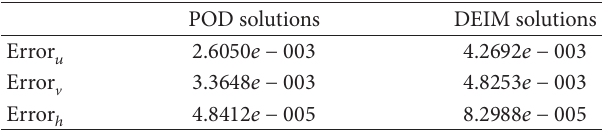
Table 1: Average relative errors for each of the model variables. The POD basesdimension is28capturing morethan 99.9% ofthesystem energy. 60 DEIM points are chosen.